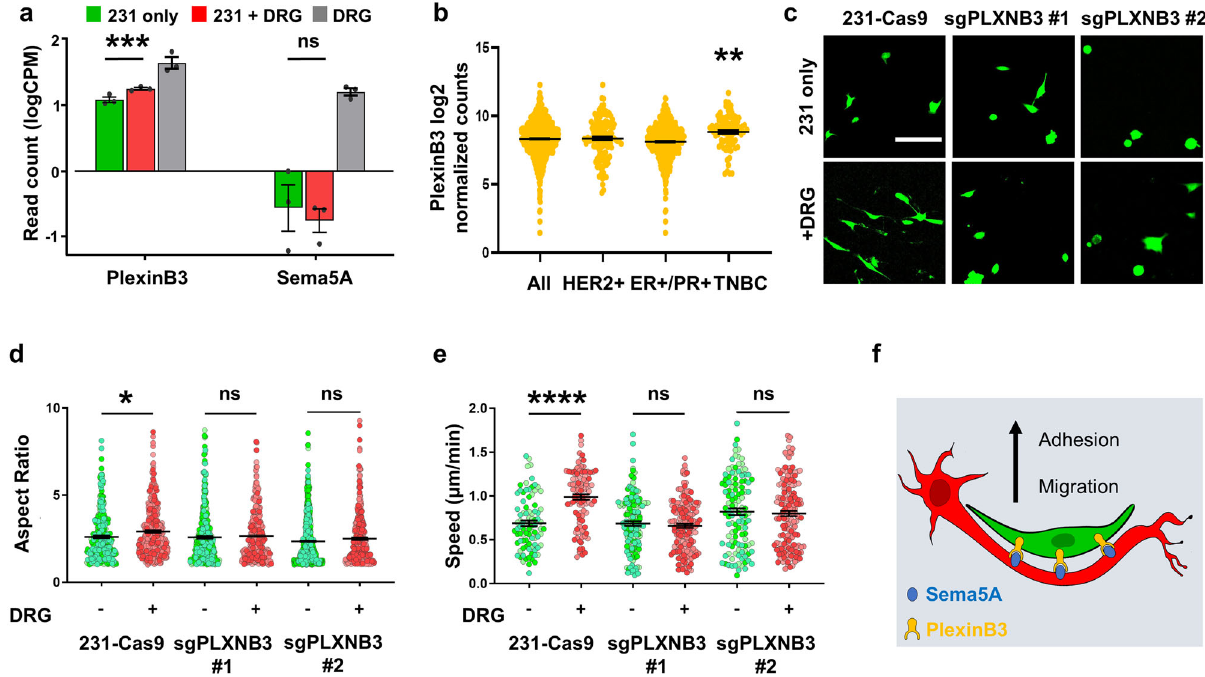
Fig. 5 PlexinB3-Sema5A signaling regulates the nerve-cancer crosstalk. a Read count of PlexinB3 and Sema5A in 231 cells and neurons (*** p < 0.001, signi fi cance was determined by EdgeR package). b PlexinB3 expression in various breast cancer subtypes, data taken from TCGA. c Representative images of 231-Cas9 and 231-sgPLXB3 cells, scale bar denoting 100 μ m. d Aspect ratio of 231-Cas9 and 231-sgPLXB3 cells, each point represents a cell, n ≥ 500 cells per condition. e 2D migration speed of 231-Cas9 and 231-sgPLXB3 #1 and #2 cells, each point represents the average speed of one tracked cell, n ≥ 150 cells per condition. f Schematic for proposed PlexinB3-Sema5A interaction. Different shades of color represent cells from different biological replicates. Data show mean ± SEM. Signi fi cance was determined by one-way ANOVA (* = 0.034, ** p < 0.01, **** p <